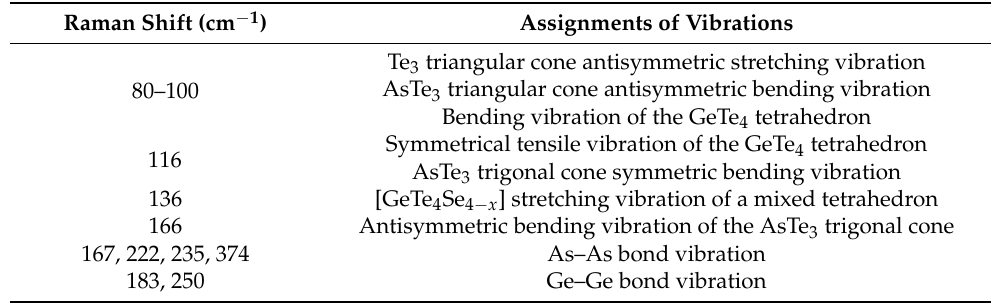
Table 3. Vibration assignments of the Raman peaks of the GAST